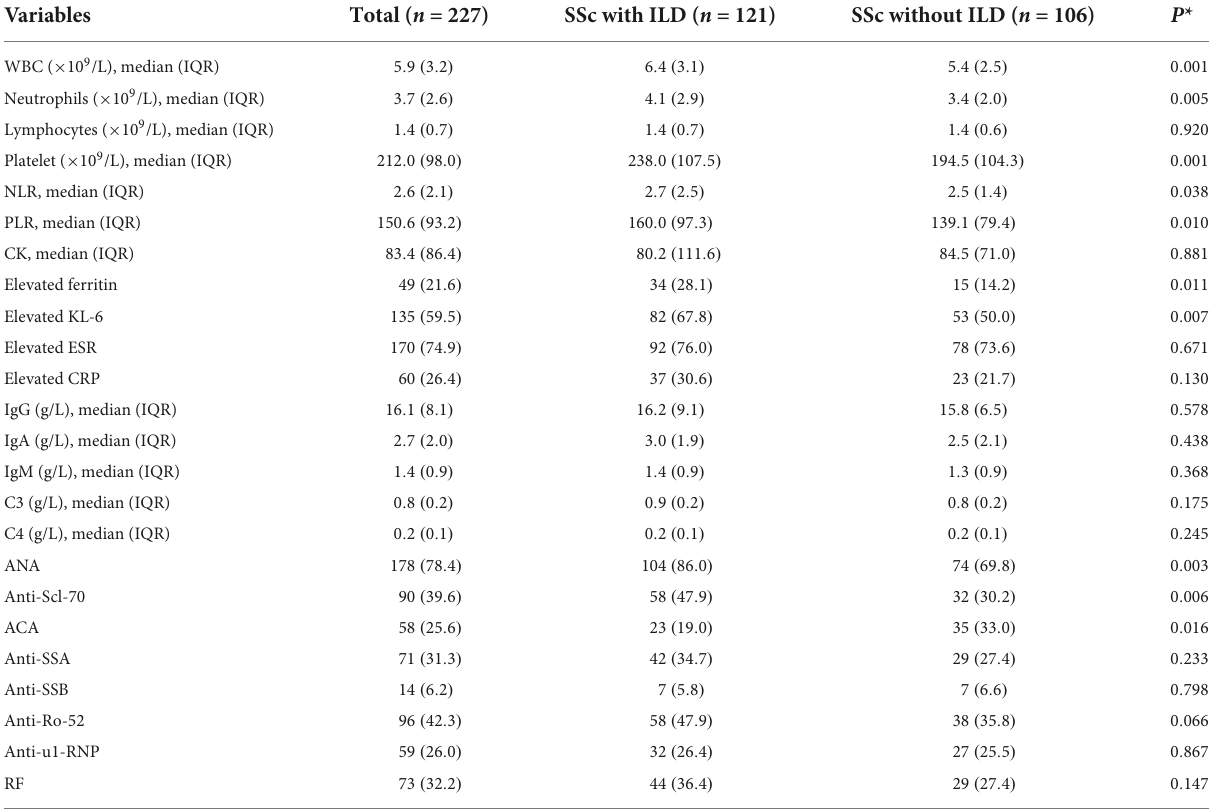
TABLE 2 Comparison of baselines laboratory features between systemic sclerosis with or without interstitial lung disease. Variables Total ( n = 227) SSc with ILD ( n = 121) SSc without ILD ( n = 106) P